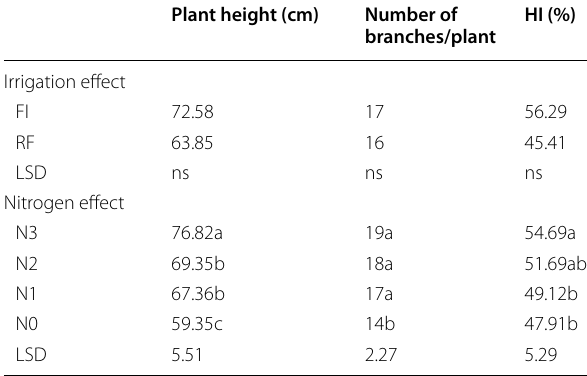
Table. 7 Means separation of plant height, number of branches per plant and HI